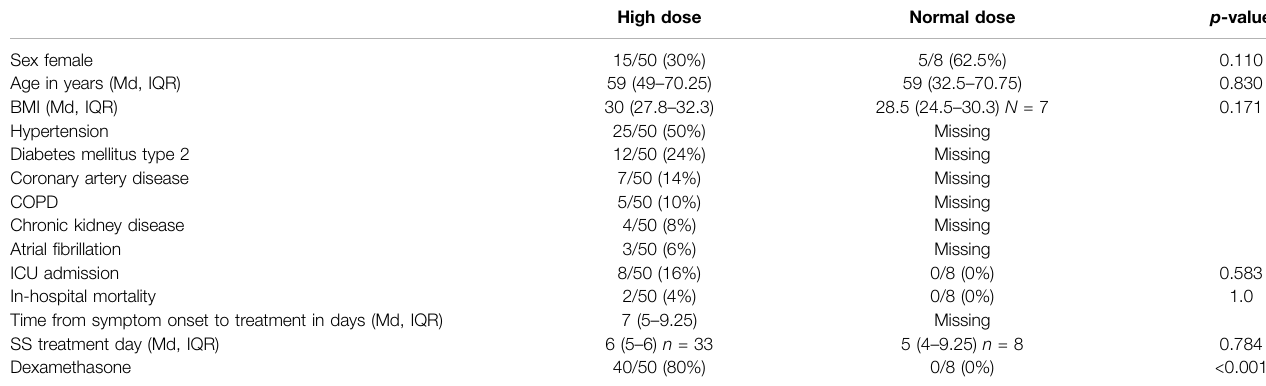
TABLE 1 | Patients characteristics.